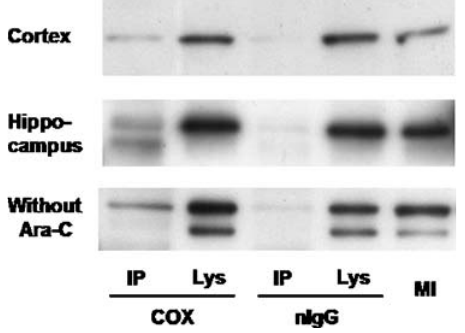
Figure 11. To probe for an association between mitochondrial cytochrome oxidase (COX) and lactate dehydrogenase (LDH), antibodies to COX and normal IgG (nIgG) were used to develop immunoprecipitates (IP) from Tween 20 (0.3%)-solubilized mitochondrial fractions of cortex and hippocampus primary cultures. Results were compared to those obtained on the supernatant remaining after immunoprecipitation (Sup). COX and nIgG immuno- precipitates were subsequently probed with an antibody that recognized all LDH isoforms. Mitochondrial fractions (MI) were also probed for LDH and results are presented as a positive control. LDH was coprecipitated with COX as compared to nIgG (no protein was coprecipitated with nIgG) in mitochondrial fractions derived from cortical as well as hippocampal areas of rat primary cultures. When the inhibitor to astrocyte development Ara-C was not used, COX coprecipitated LDH in mitochondrial fractions from cortical and hippocampal areas of rat primary cultures. Similar results obtained with and without Ara-C (the lack of Ara-C facilitates development of astrocytes among as neurons in cultures) indicate that astrocytes also contain mLDH.